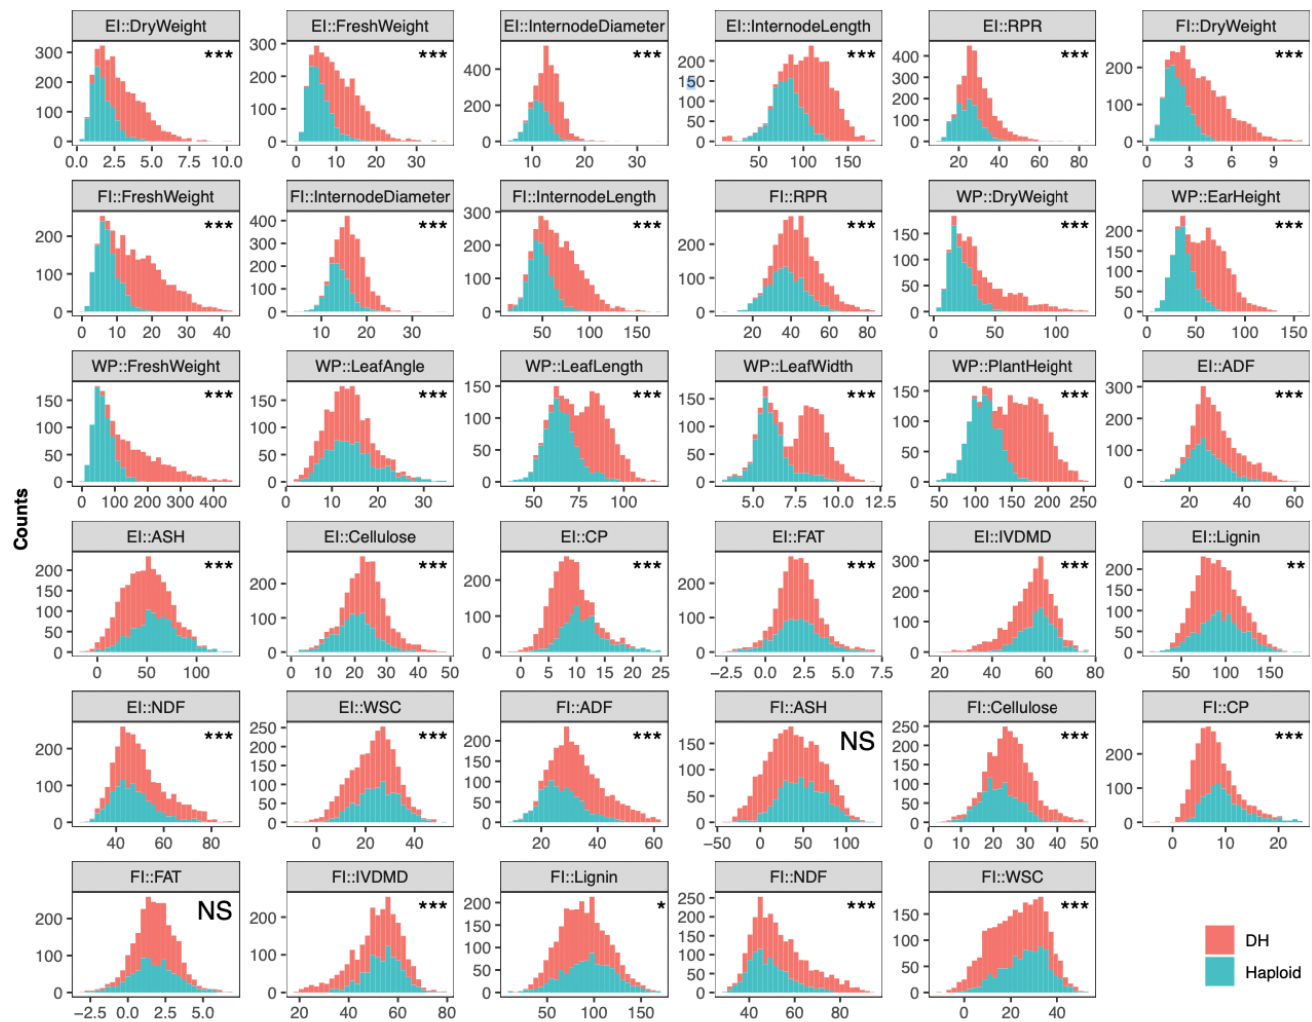
Figure 1. Phenotypic value distributions of the DH and haploid populations for each of the 35 traits. For each trait, histograms of the two populations were plotted independently and based on all phenotypic values across four environments. The t -test was applied to test the mean difference between the two populations for each trait, for which *** = significant at p < 0.001, ** = significant at p < 0.01, * = significant at p < 0.05, and NS = not significant.